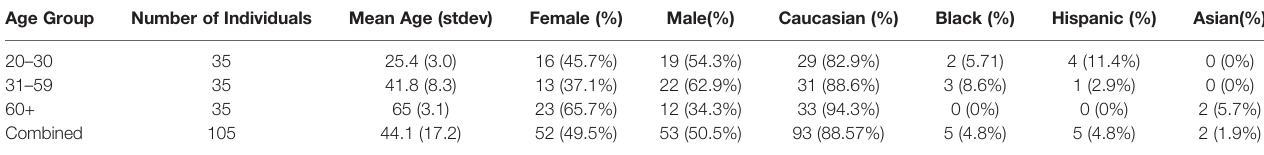
TABLE 1 | Age, sex, and race breakdowns for healthy human subjects in each age group. Age Group Number of